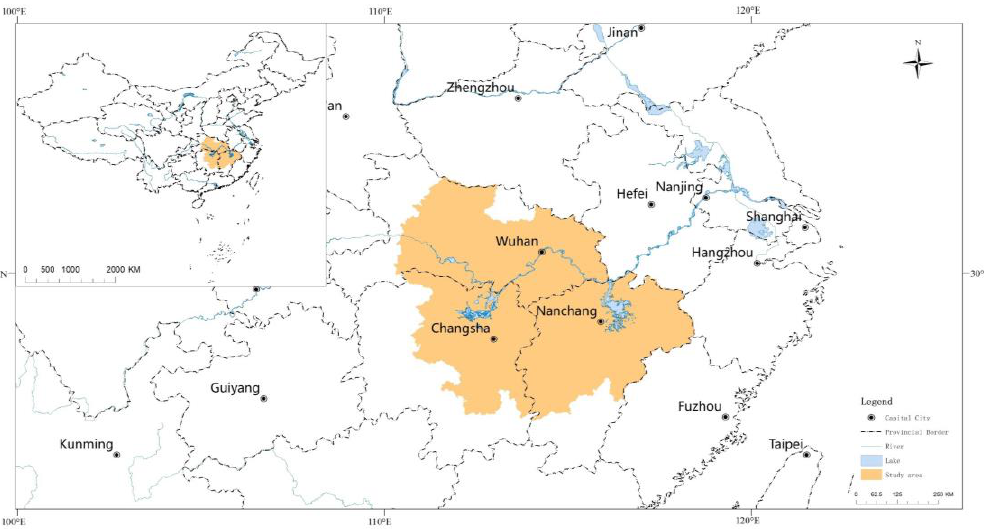
Figure 2. Geographical location and main cities of the middle reaches of the Yangtze River. Source: National Foundation Geographic Information Center and own elaboration.